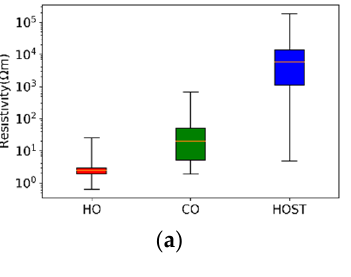
Figure 4. Box plots of the ( a ) electrical resistivity, ( b ) chargeability, and ( c ) magnetic susceptibility of rock samples classified as high-grade ore (HO), candidate ore deposit (CO), and host rocks (HOST).